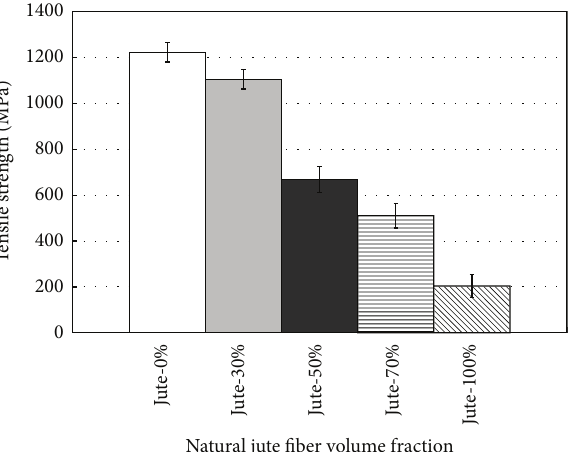
Figure 11: Tensile strength of HGJFRP composite